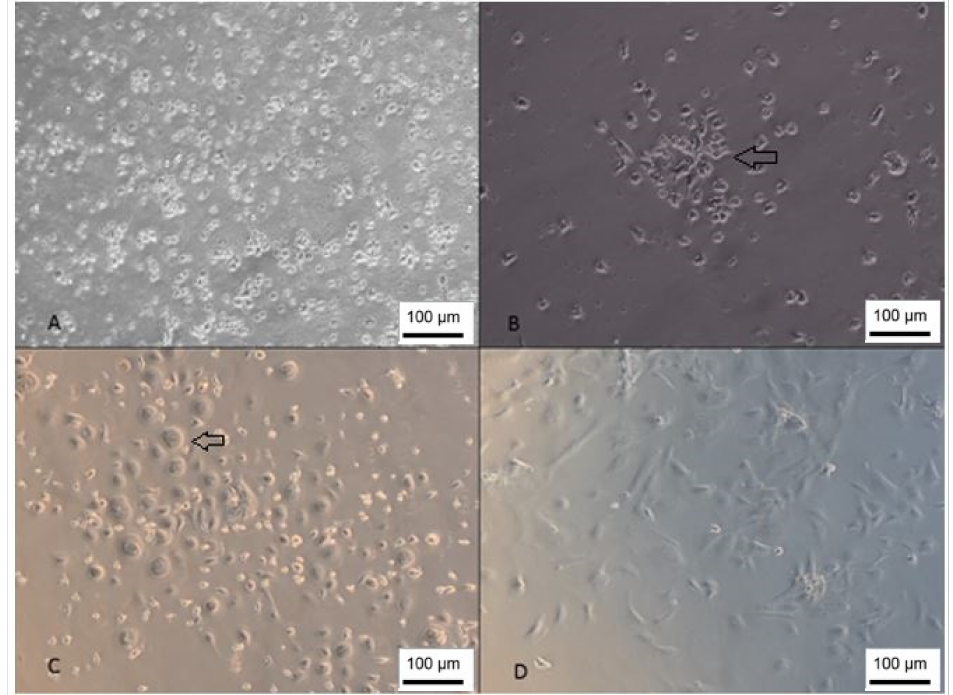
Figure 2. Isolation of UCB-MSC. ( A ) Cells 1 day after isolation; ( B ) day 7—growth in colonies; ( C ) day 15—cells with rounded morphology; ( D ) cells 26 days after isolation (inverted optical microscopy, 100 X). Scale bar, 100 µ